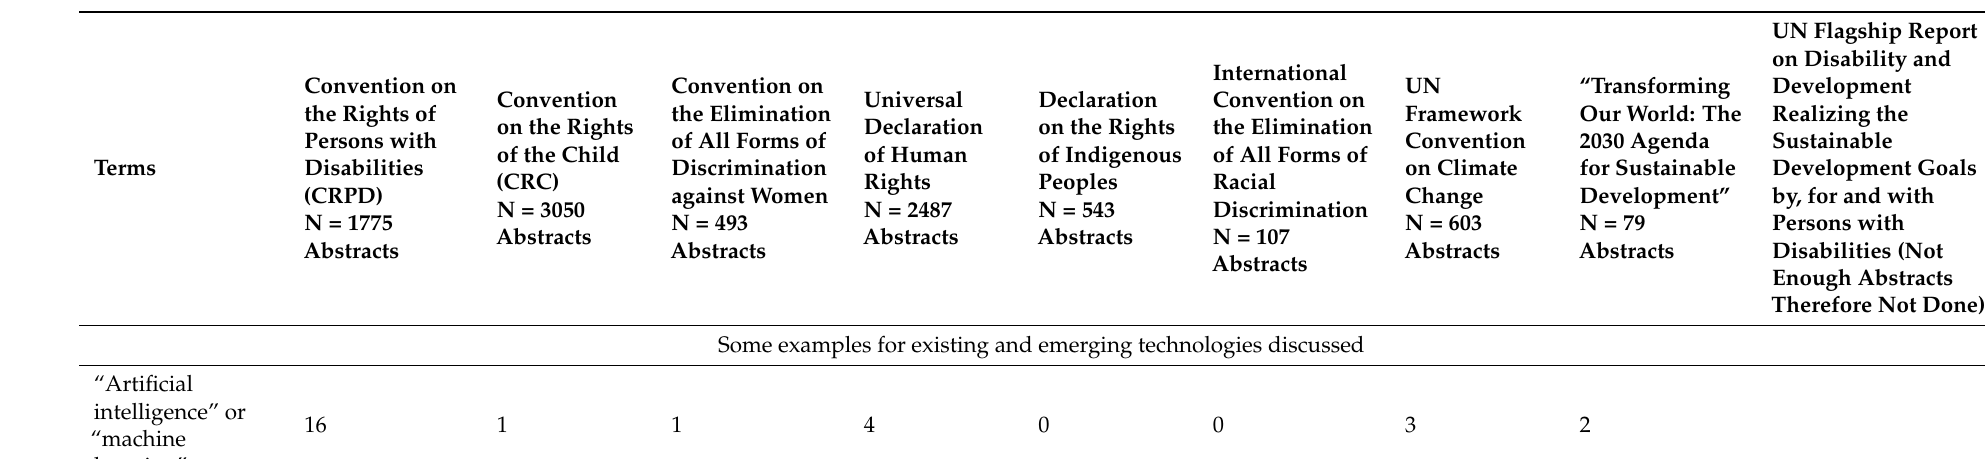
Table 20. hitcounts for some established and emerging technologies we selected that are discussed as having an impact on the ‘social’ of abstracts mentioning